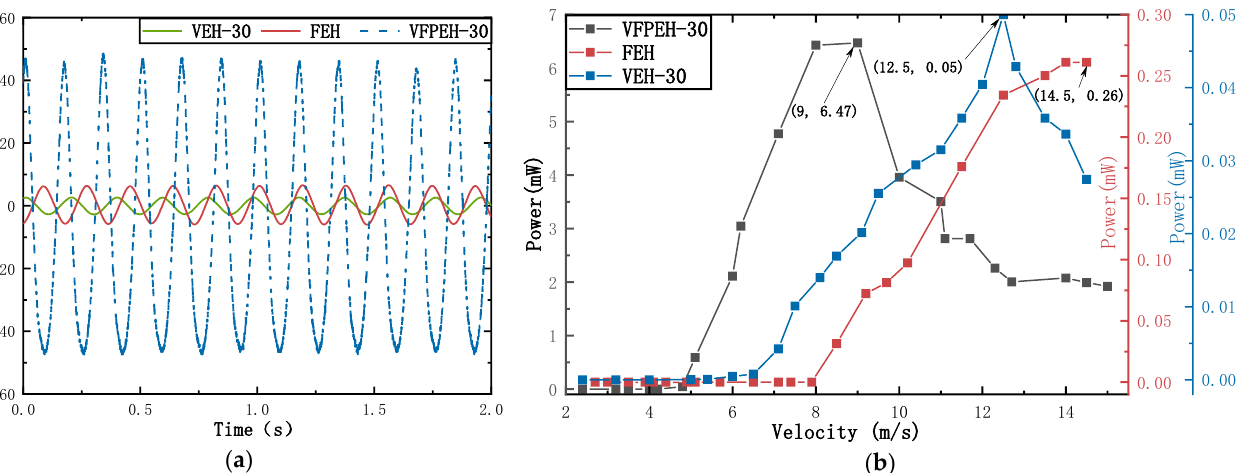
Table 6. Key characteristics of the three energy harvesters .